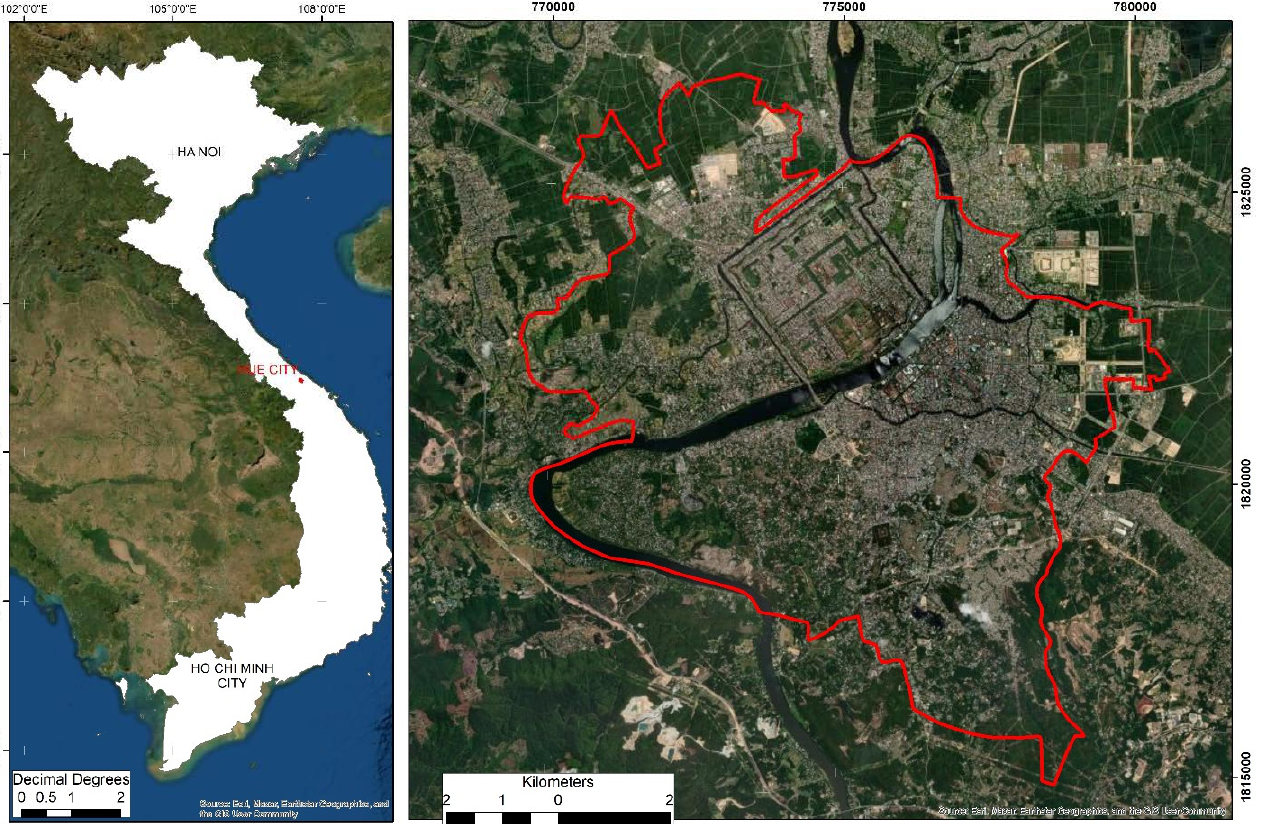
Figure 1. The location of Hue in Vietnam ( Sources: GADM database; https://gadm.org/data.html; 20 May 2021 ).